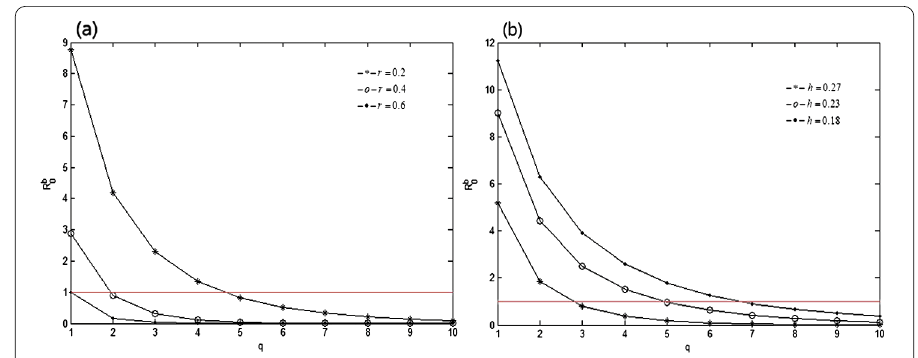
Figure 4 ( a ) The effect of the pest’s net uptake rate r of pesticide from the environment on the threshold R b 0 , h = 0.2. ( b ) The effect of the pesticide loss rate h from the environment itself on the threshold R b 0 , r = 0.2. The other parameters are b = 20, μ = 0.4, d = 0.4, δ = 0.6, g =